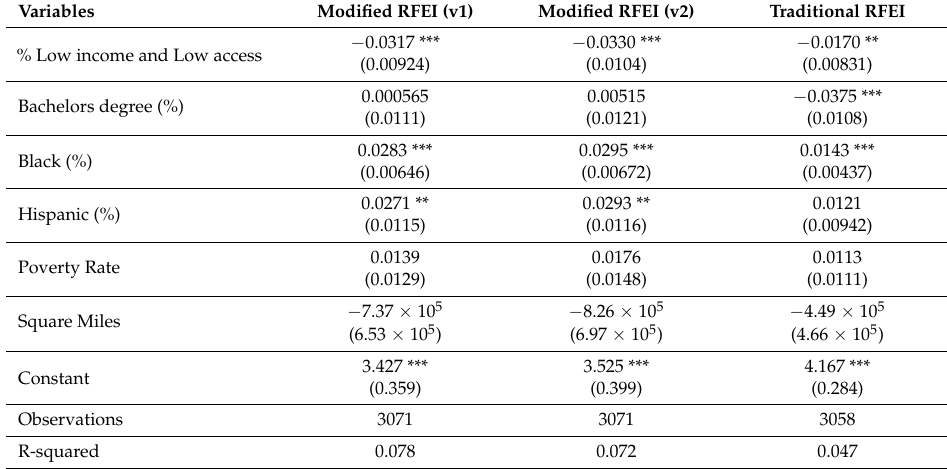
Table A2. OLS coefficient estimates of low income and low access (food desert measure) on three food swamp measures.